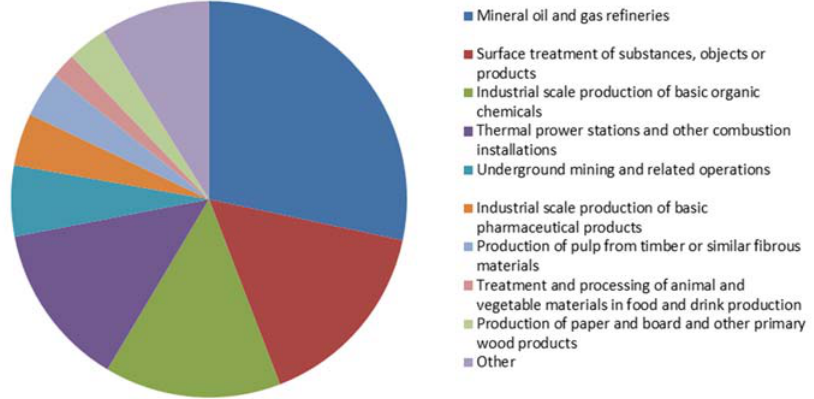
Figure 4. NMVOC emissions shares from different source categories in European countries in 2011 (Data collected from [324]).